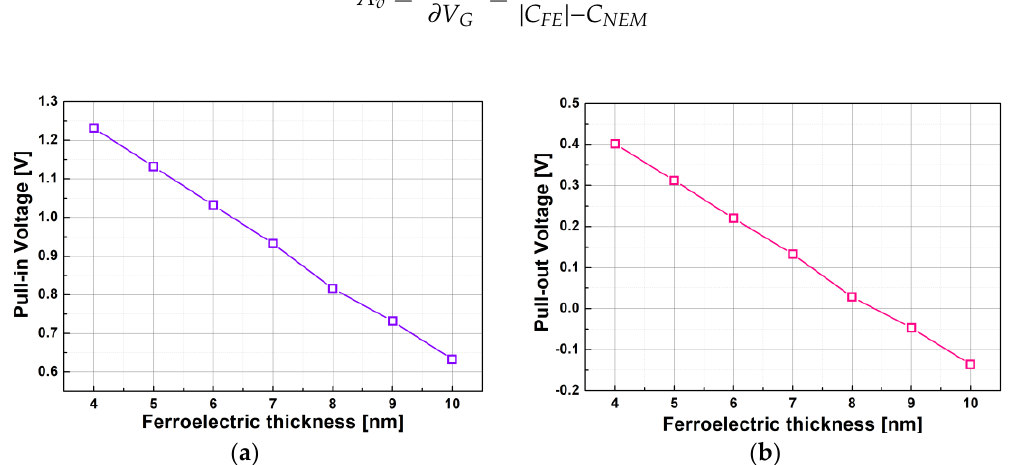
Figure 8. Estimated ( a ) pull-in voltage and ( b ) pull-out voltage of NEM relay with multi-domain ferroelectric with various ferroelectric thicknesses. Note that pull-in / -out voltage is decreased with increasing ferroelectric thickness.